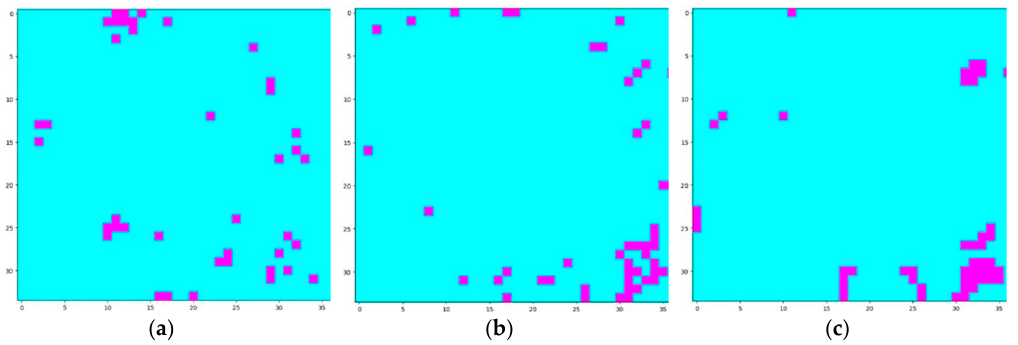
Figure 11. ( a ) Simple count query (SCQ) result of the top-50 ROI queries. ( b ) ROI vector (ROI2VEC) result of the top-50 ROI queries. ( c ) ROI2VEC + TF-IDF + Gaussian kernel (RALL) result of the top-50 ROI queries.